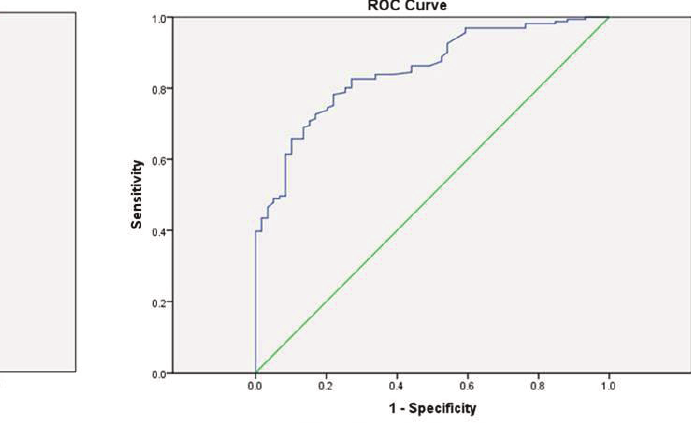
Figure 2: Diagnosis of HE4 boundary values with healthy women as for